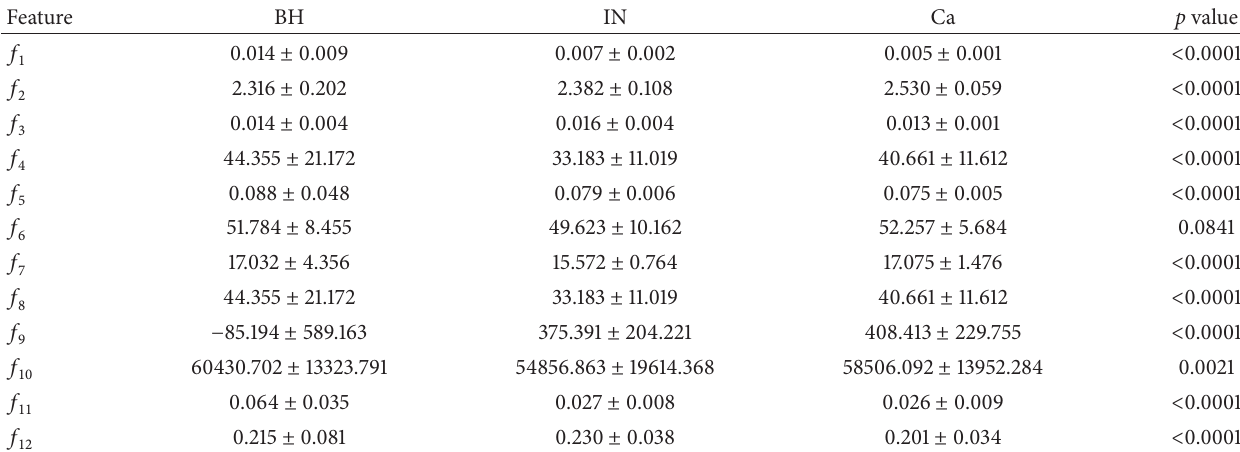
Table 3: Comparison of ABC texture features (mean ± STD) between BH, IN, and Ca.